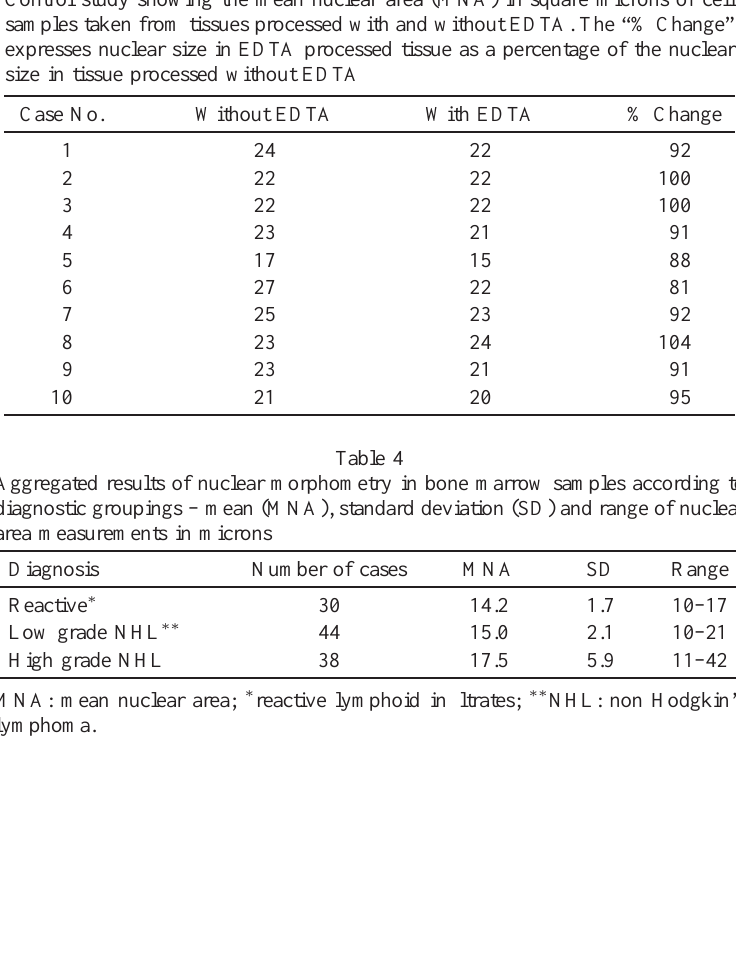
Table 3 Control study showing the mean nuclear area (MNA) in square microns of cell